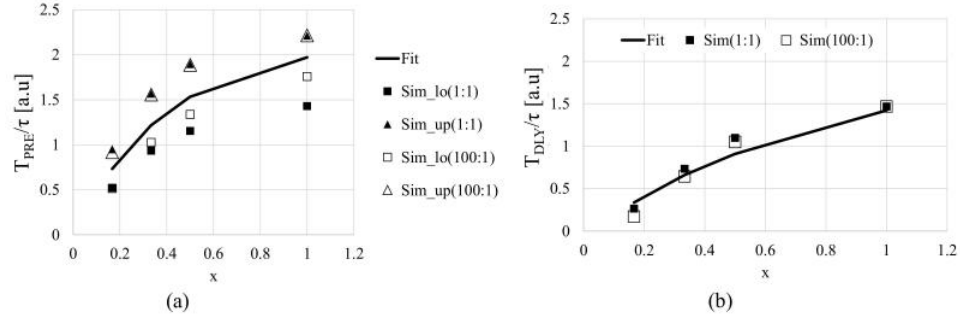
Figure 19. Fitting and simulated curves for T PRE vs. x ( a ) and T DLY vs. x ( b ), whose data is taken from Figure